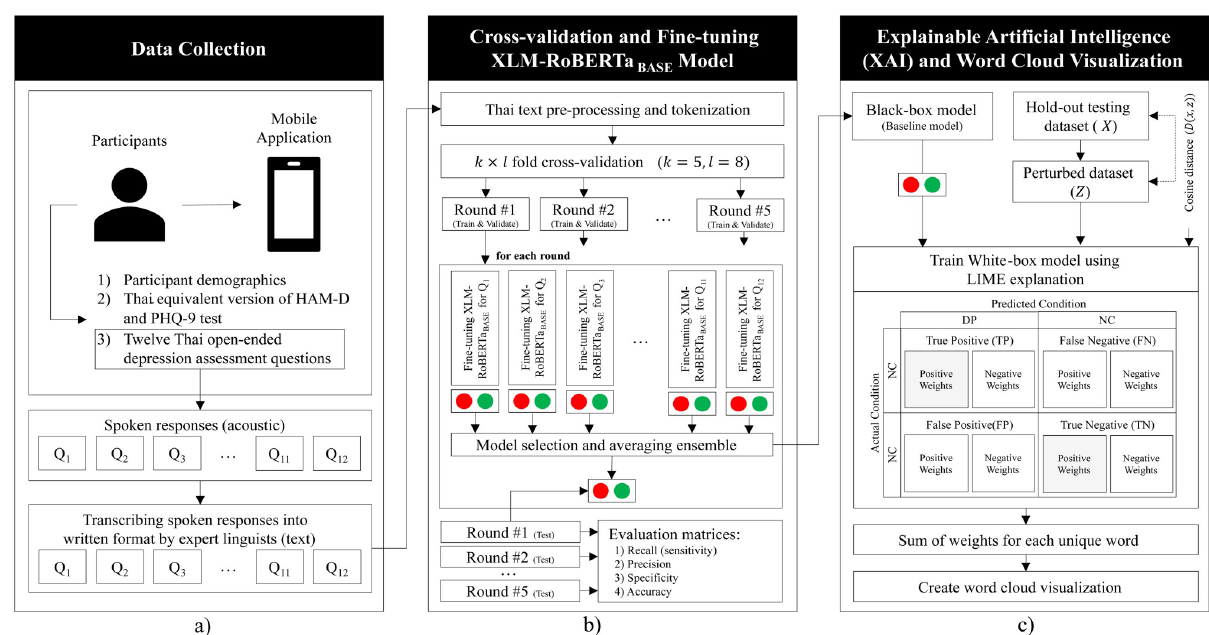
Fig 1. A flow diagram of the article’s process including a) data collection and speech elicitation, which are then transformed into text transcriptions; b) text pre-processing and normalization, followed by data preparation for cross-validation in transfer learning to the model for each question to compute evaluation matrices; c) training of the model for LIME explanation and utilization of the weights from the explanation for creating word clouds for both the normal control group and the depression group.